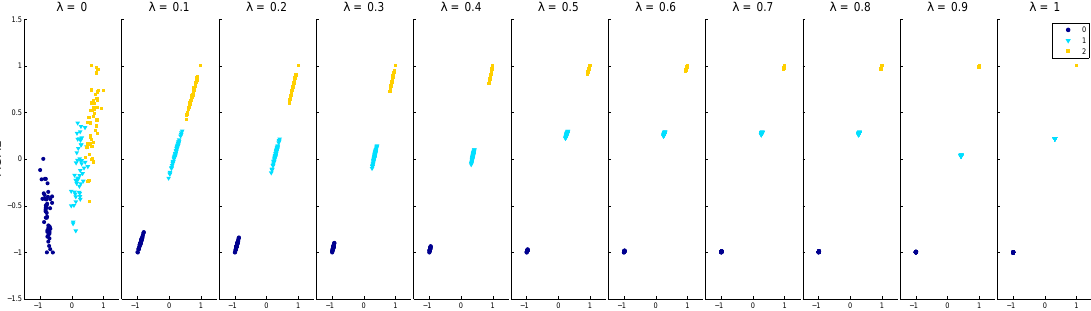
Figure 1. Projections of the Iris dataset with λ value from 0 to 1. The colour is used to help illustrate different clusters here, and was not used in the actual